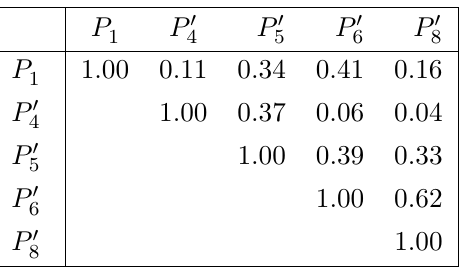
Table 9 . Statistical correlation matrix for the P (